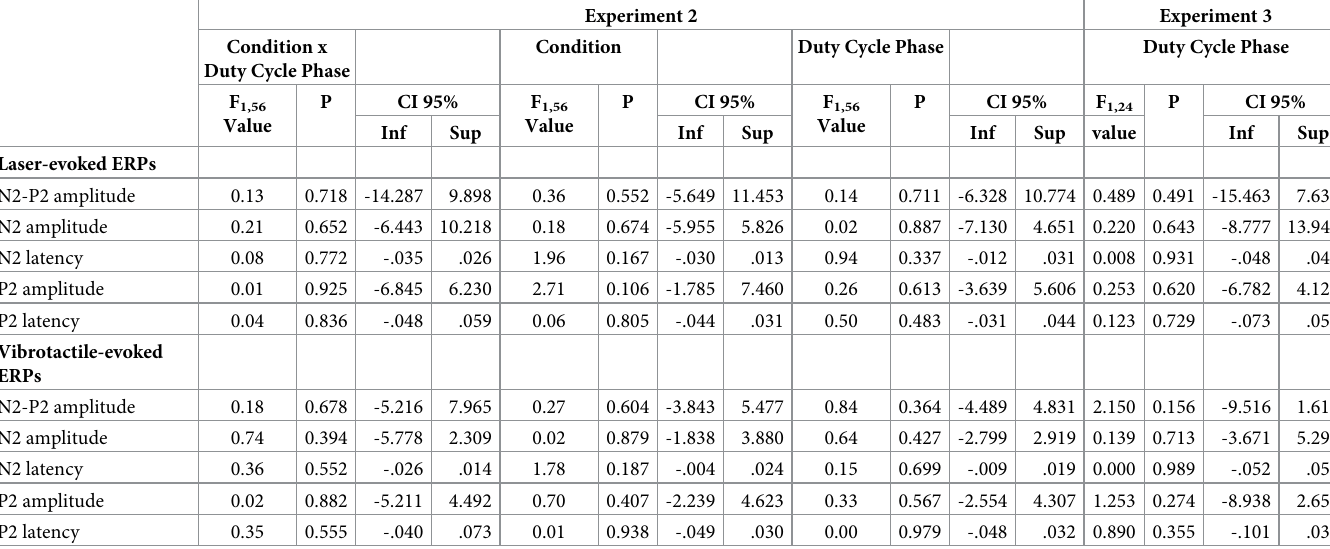
Table 8. Linear mixed models with within-subject factors condition and duty cycle phase: Cerebral responses (Experiment